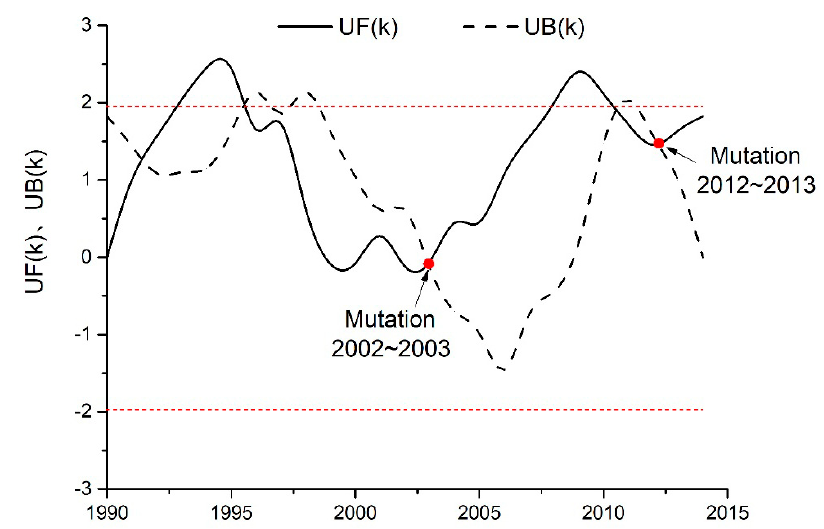
Figure 8. The M-K test results of the phragmite area from 1990 to 2014.